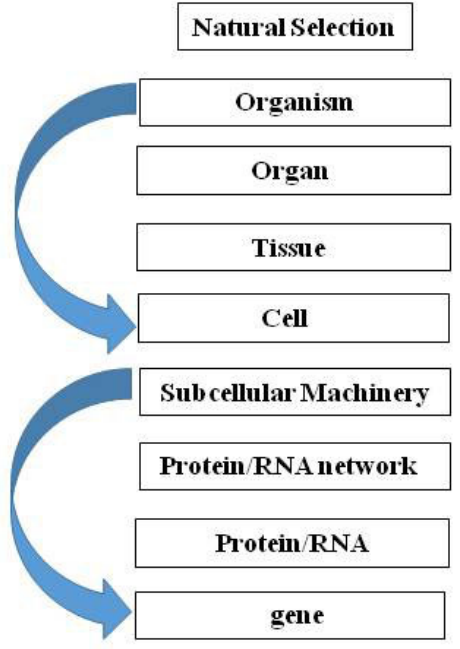
Figure 1. Downward Causation. Teleologically, there is no privileged level of causality in biological